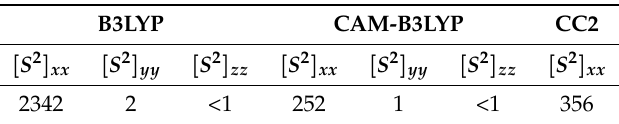
Table 2. Harmonic vibrational contribution to δ 2PA for the S 2 ← S 0 transition. All values are given in au and were computed using the cc-pVTZ basis